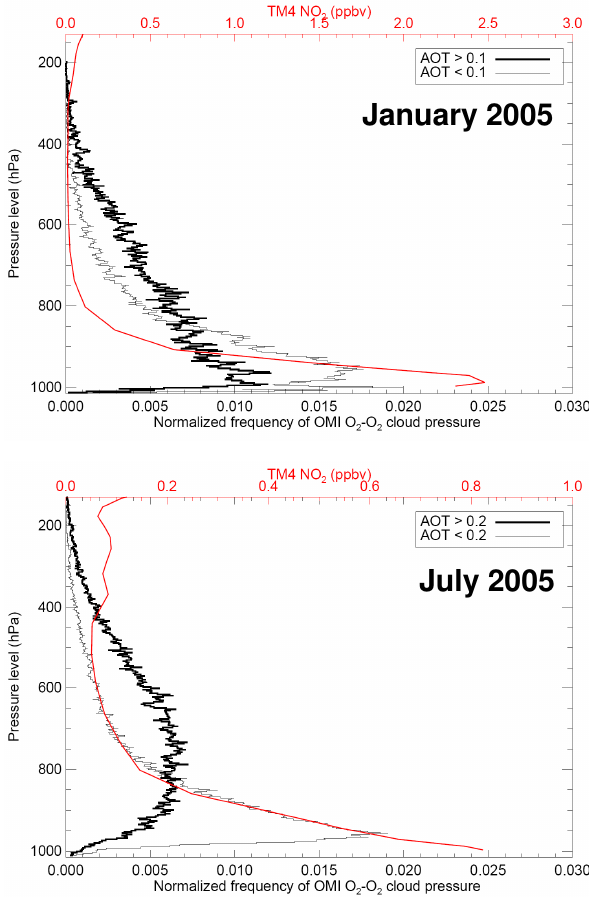
Fig. 13. Probability density functions for OMI O 2 -O 2 cloud pressure levels in January 2005 (upper panel), and July 2005 (lower panel). In both panels, the pdf for the ’hazy’ southern United States (January: MODIS > 0.1, July: MODIS > 0.2) is indicated by the thick black line, and the pdf for the clean part of the domain (January: MODIS < 0.1, July: MODIS < 0.2) has been indicated by the thin line. The red lines in both panels indicate the average vertical distribution of NO 2 (layer columns) simulated by TM4 for the ’hazy’ region. The upper x-axis units are in ppbv.